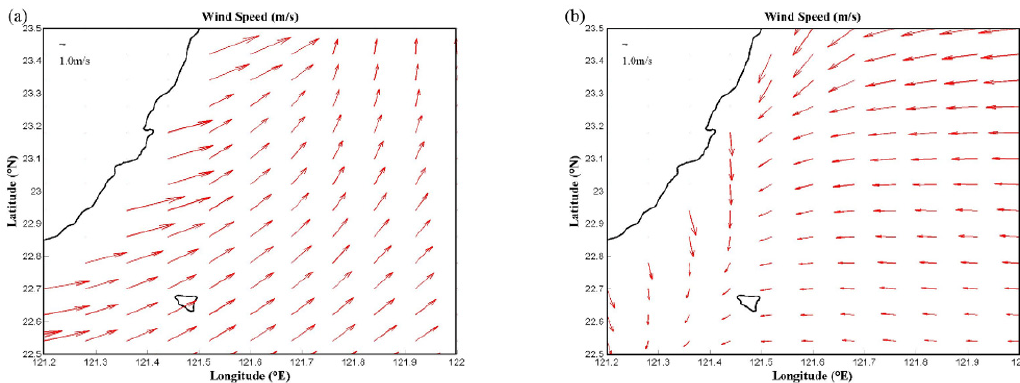
Figure 12. Velocity fields of ( a ) the SW wind condition and ( b ) the NE wind condition.